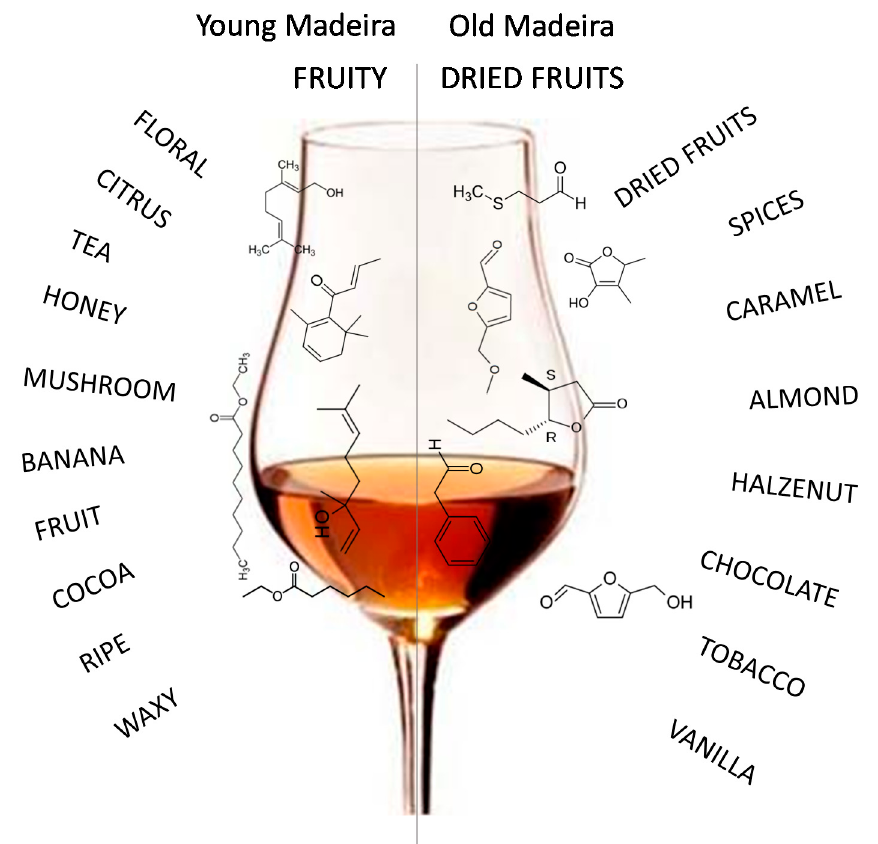
Figure 6. Characteristic aroma notes in young and old Madeira wines.